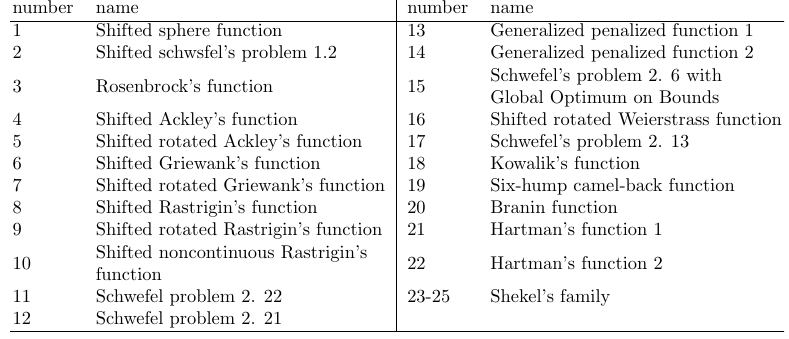
Figure 2. Test function.